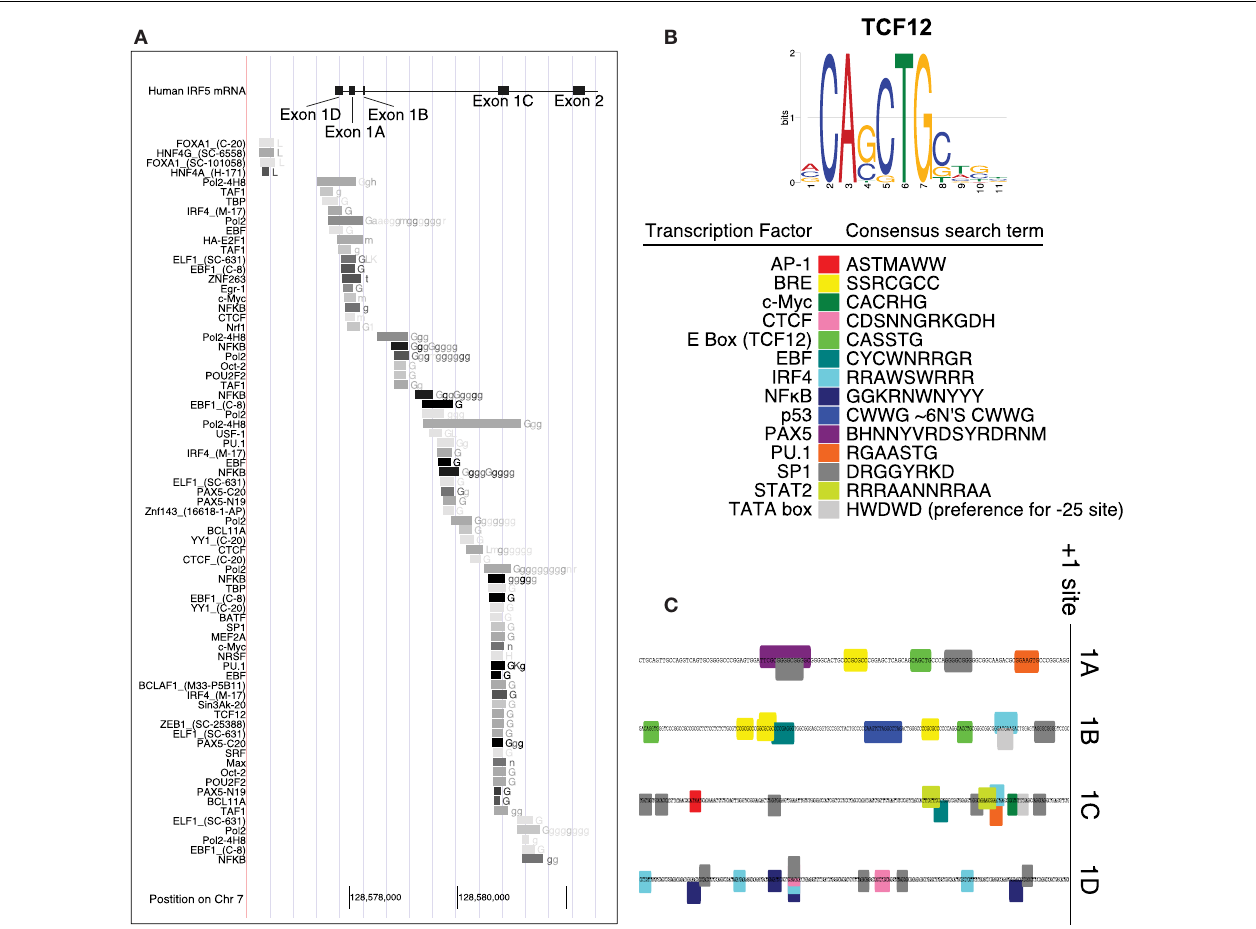
color-coded boxes representing the binding sites or transcription factors shown in the key. AP, activator protein; BRE, B-response element; CTCF, CCCTC binding factor;TCF, transcription factor; EBF, early B cell factor; IRF, interferon regulatory factor; NF κ B, nuclear factor kappa light chain enhancer of activated B cells; PAX, paired box; PU, purine rich; SP, specificity protein; STAT, signal transducer and activator of proteins;TATA, thymidine